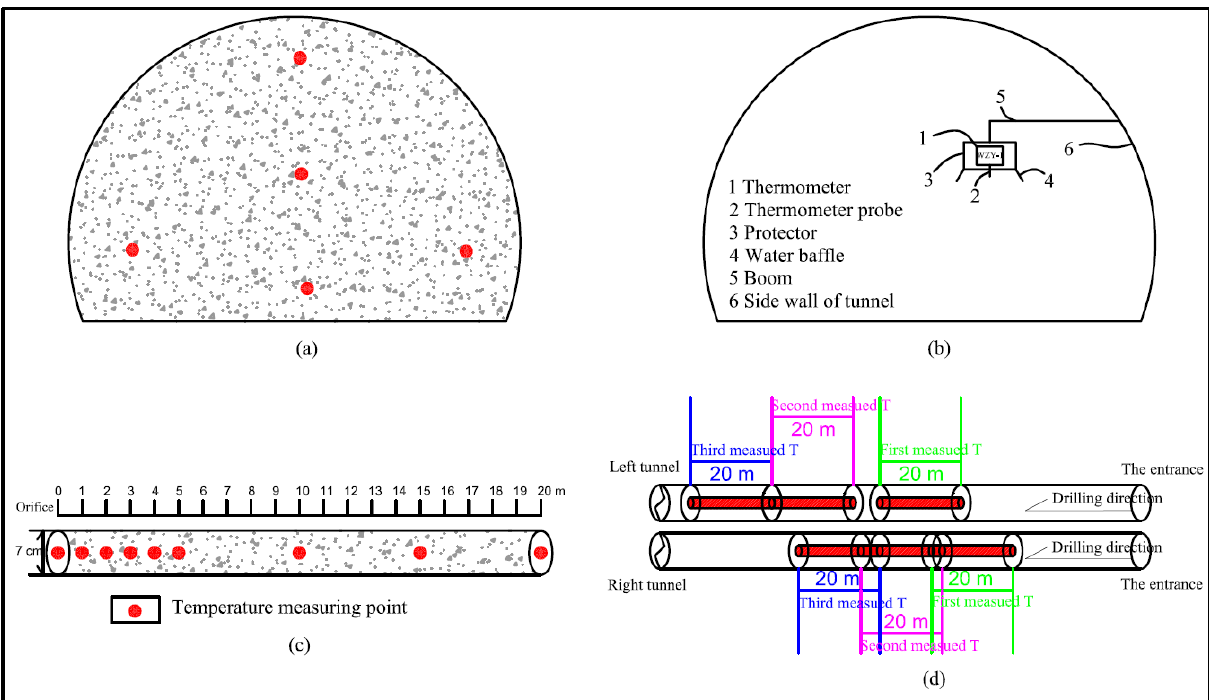
Figure 2. Layout of temperature measuring points and their installation: ( a ) Layout of temperature measuring point in tunnel face; ( b ) Layout of air temperature measuring device for each construction link; ( c ) Layout of temperature measuring point in advance drilling; ( d ) Layout of advanced